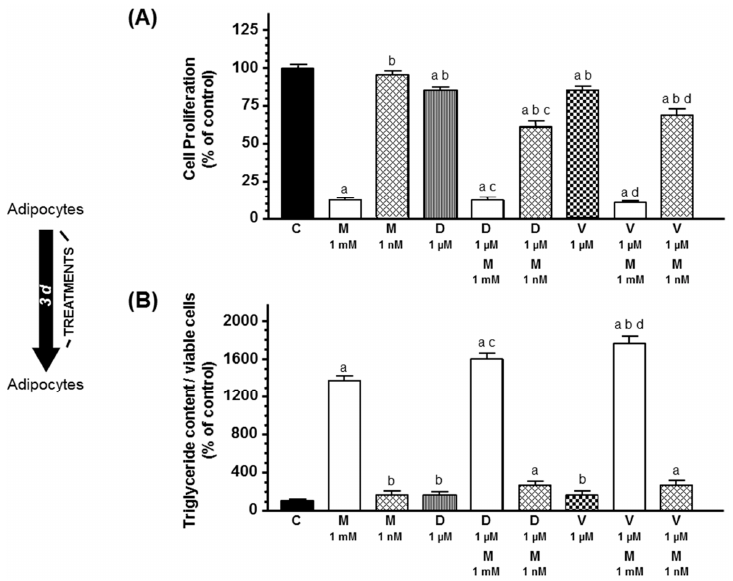
Figure 2. Effects of melatonin on docetaxel- and vinorelbine-induced changes on (A) cell proliferation and (B) intracytoplasmic triglyceride content on differentiating human breast adipocytes. Breast preadipocytes completely differentiated into adipocytes were treated with docetaxel (1 µM), vinorelbine (1 µM), and/or melatonin (1 mM or 1 nM) for 3 days. ( A ) Cell proliferation was measured by the MTT method. ( B ) Intracytoplasmic triglyceride accumulation was quantified by the Oil Red O staining method. Data are expressed as the percentage of the control group (mean ± SEM). a, p < 0.001 vs. C; b, p < 0.001 vs. M (1 mM); c, p < 0.001 vs. D (1 µM); d, p < 0.001 vs. V (1 µM). C: control, M: melatonin, D: docetaxel, V: vinorelbine. Then, since malignant cells secrete cytokines that prevent the differentiation of preadipocytes to adipocytes, we studied the effects of docetaxel, vinorelbine, and melatonin on adipogenic differentiation, in co-cultures of human breast preadipocytes and human breast cancer cells. According to previous findings, the presence of malignant epithelial cells decreased triglyceride content. Docetaxel and vinorelbine increased adipogenic differentiation. Melatonin only at 1 mM concentration stimulated adipogenesis differentiation and potentiated the stimulatory effect induced by docetaxel and vinorelbine (Figure 3).